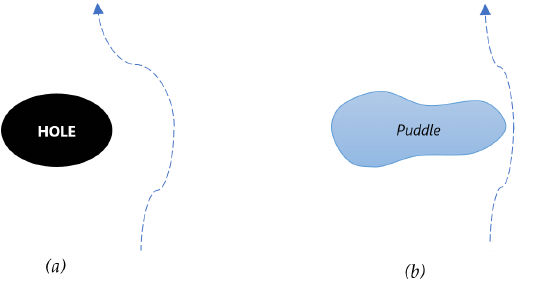
Figure 1. The agent’s planned path with different obstacle’s danger: ( a ) Navigation around a deep hole; ( b ) navigation around a water